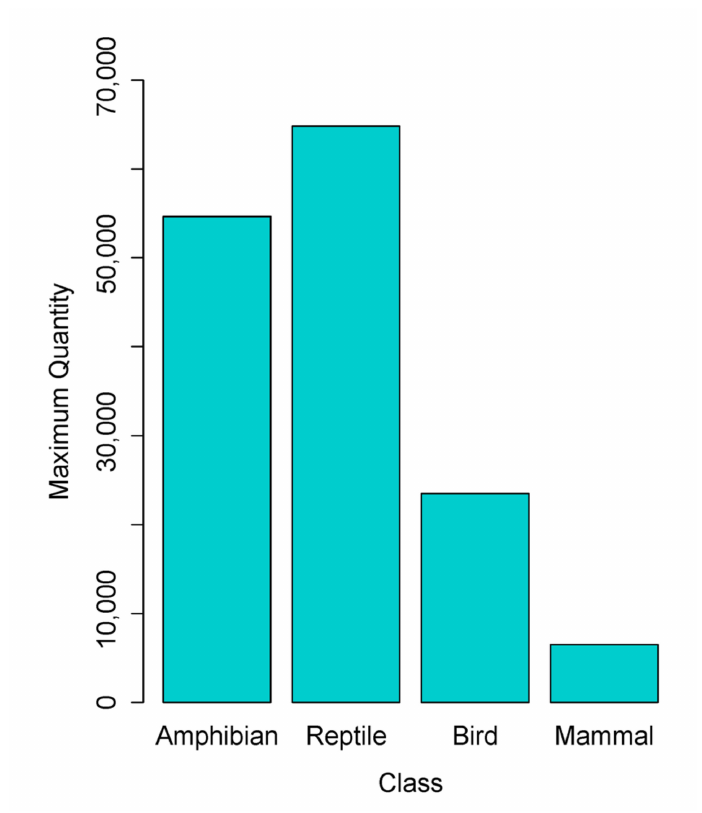
Figure 1. Total (maximum) number of amphibians, reptiles, birds, and mammals permitted for sale across UK (England, Scotland, and Wales only) pet shop licences in